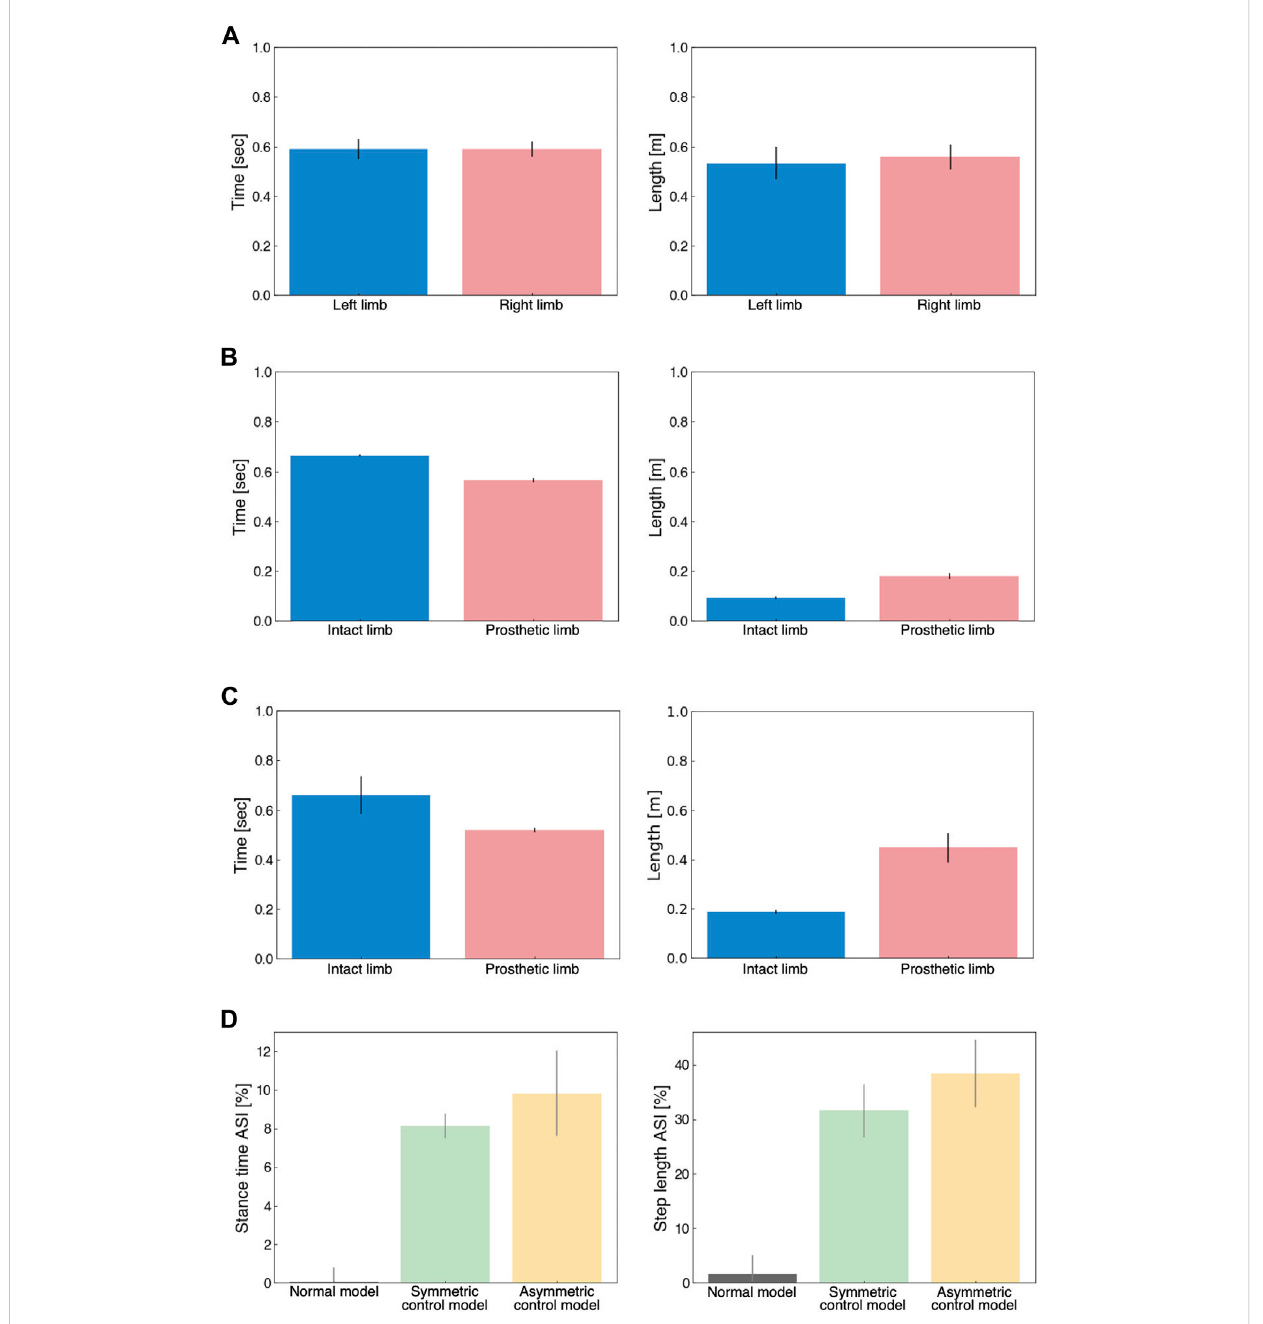
FIGURE 6 Analysisofspatiotemporalgaitpatterns. (A) Stancetime(leftpanel)andsteplength(rightpanel)forthenormalmodel. (B) Stancetime(leftpanel)and step length (right panel) for the symmetrical control model. (C) Stance time (left panel) and step length (right panel) for the asymmetrical control model. (D) Stance time ASI (left panel) and step length ASI (right panel) for the normal model (grey), symmetric control model (green), and asymmetric control model